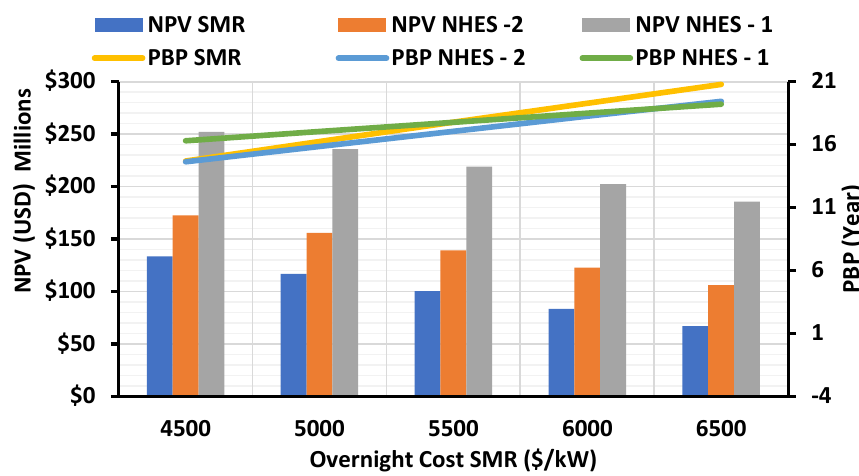
Figure 13. NPV and PBP vs. overnight cost of advanced SMR for California region.